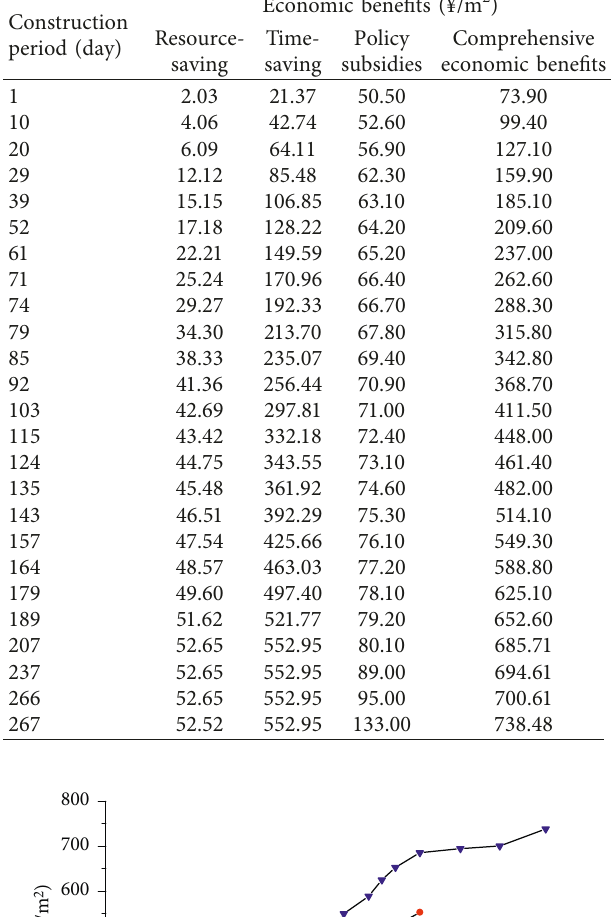
Table 6: Economic benefit values on main days in the project. Construction